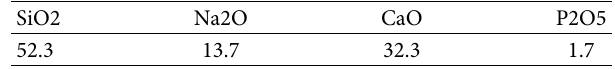
Table 1: Bioactive glass composition